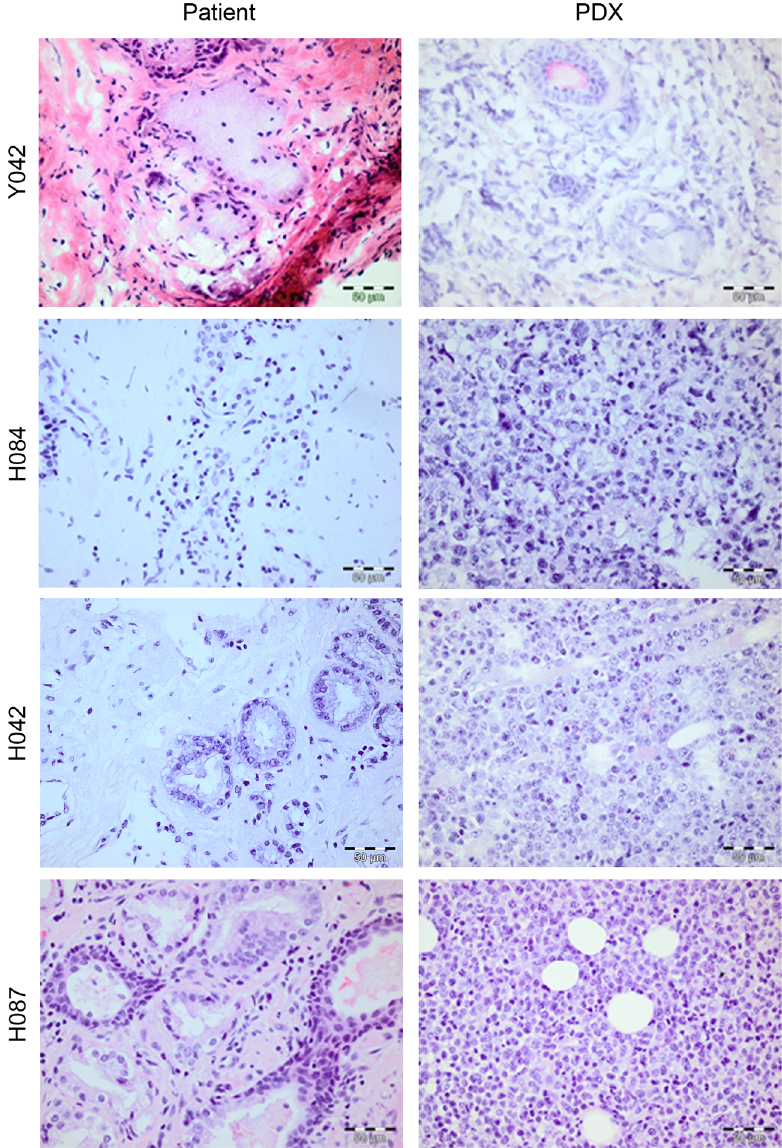
Fig 1. Primary tumour xenografts derived from treatment-na ï ve human prostate tissue specimens. H&E sections of representative prostate cancer xenografts and their corresponding humandonor sample. Note loss of